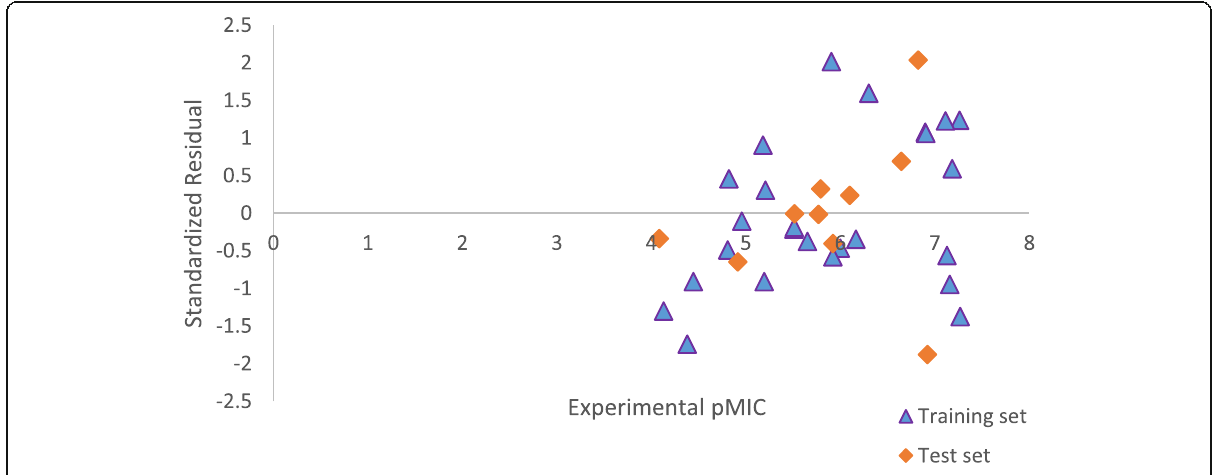
Fig. 2 The scatter plot of standardized residual versus experimental pMIC